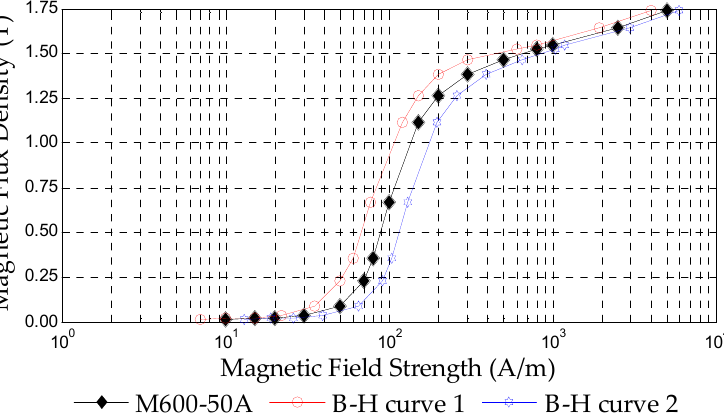
Figure 3. The B-H curve of the M600-50A electrical steel and its modifications formed through increasing (B-H curve 1) and decreasing (B-H curve 2) the slope of the M600-50A B-H curve. Table 2. The x -axis and y -axis components of the SC space vector and the slip frequency at the modification of the stator and rotor B-H curve slope of the FE model. B-H Curves Quantity.